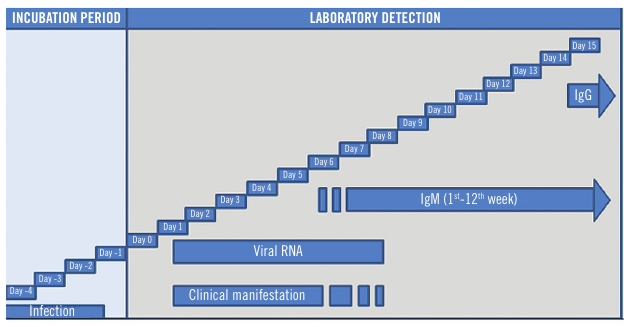
IncubatIon perIod Laboratory detectIon